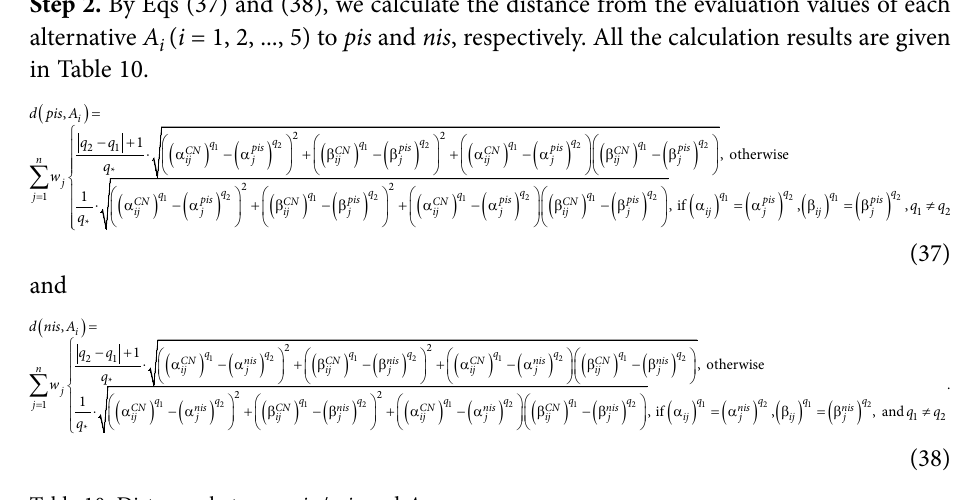
Table 10. Distances between pis / nis and A i